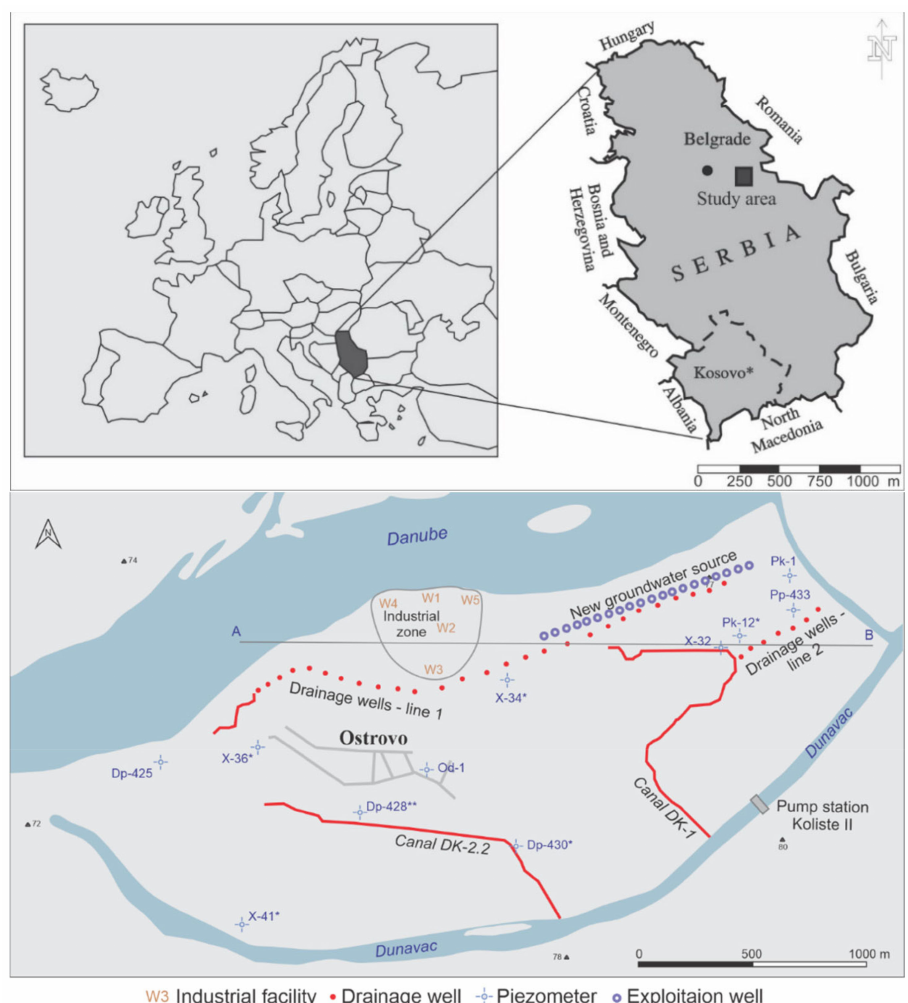
Figure 1. Location map of the study area.